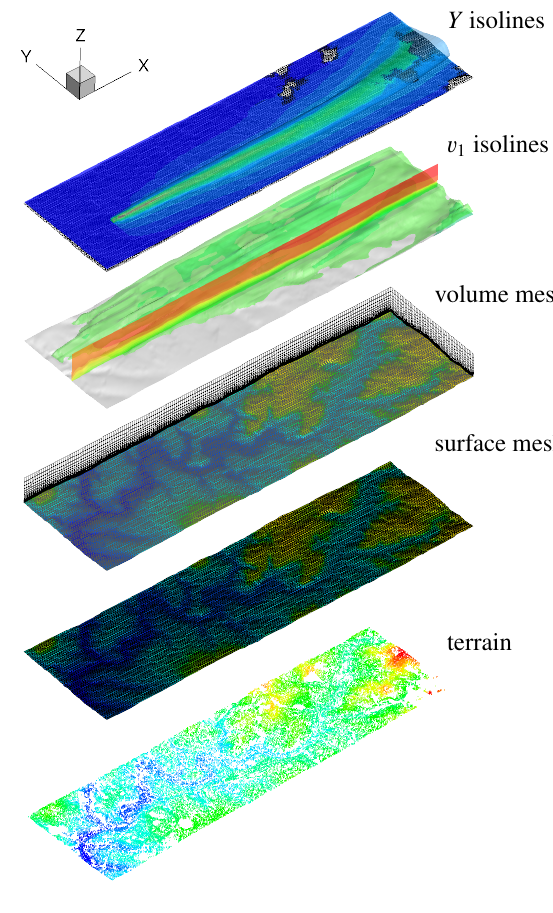
Fig. 4. The simulation of the flow over the terrain: (from bottom) set of points, surface mesh, volume mesh, isolines of velocity, isolines of the mass fraction Y